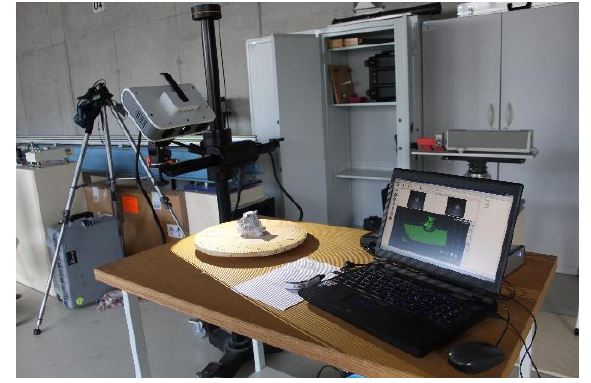
Figure 7: Structured light system experimental